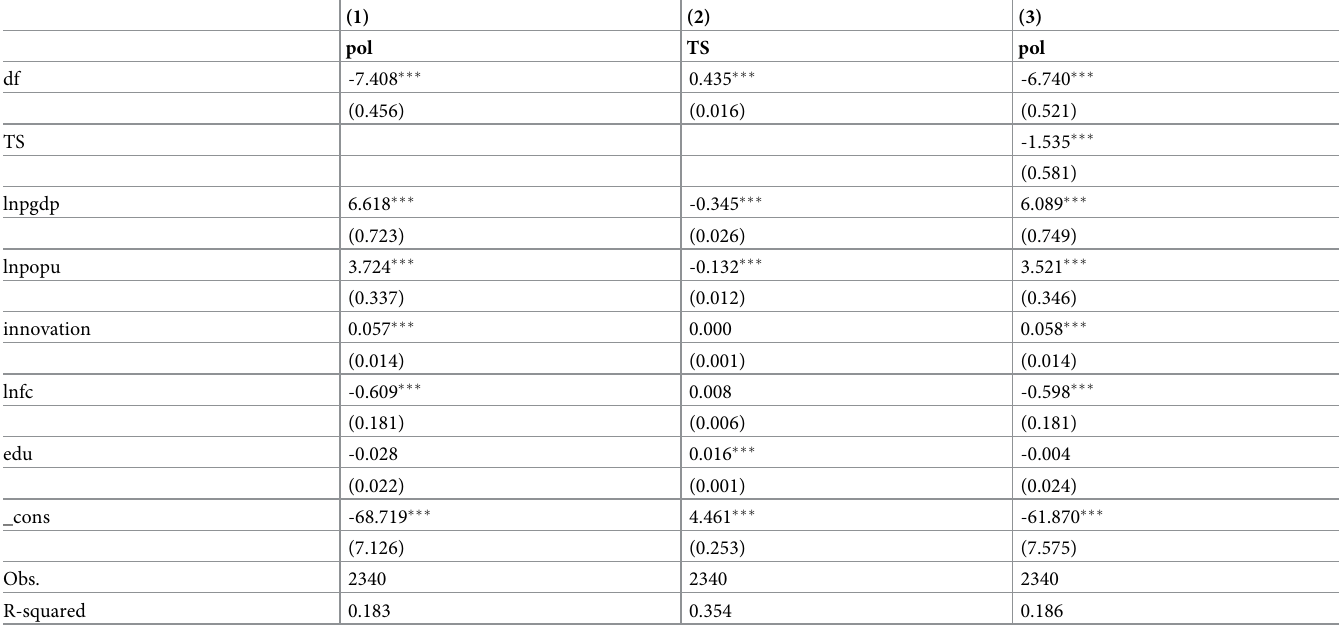
Table 6. Mediating effects regression results.